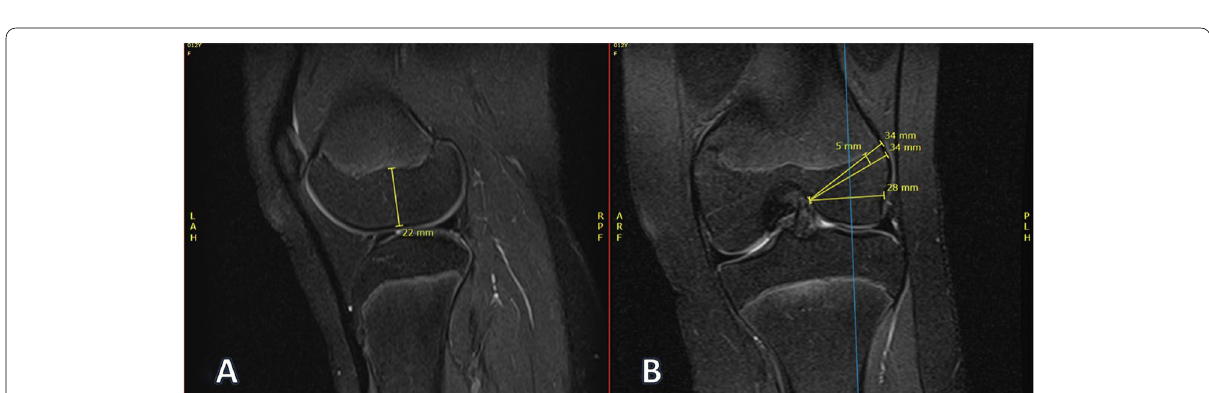
Fig. 4 Example femoral epiphysis measurements. A Femoral epiphysis height (22 mm). B Femoral tunnels from top to bottom: maximum oblique (34 mm), physeal sparing (5 mm from physis, 34 mm), and direct horizontal (28 mm)